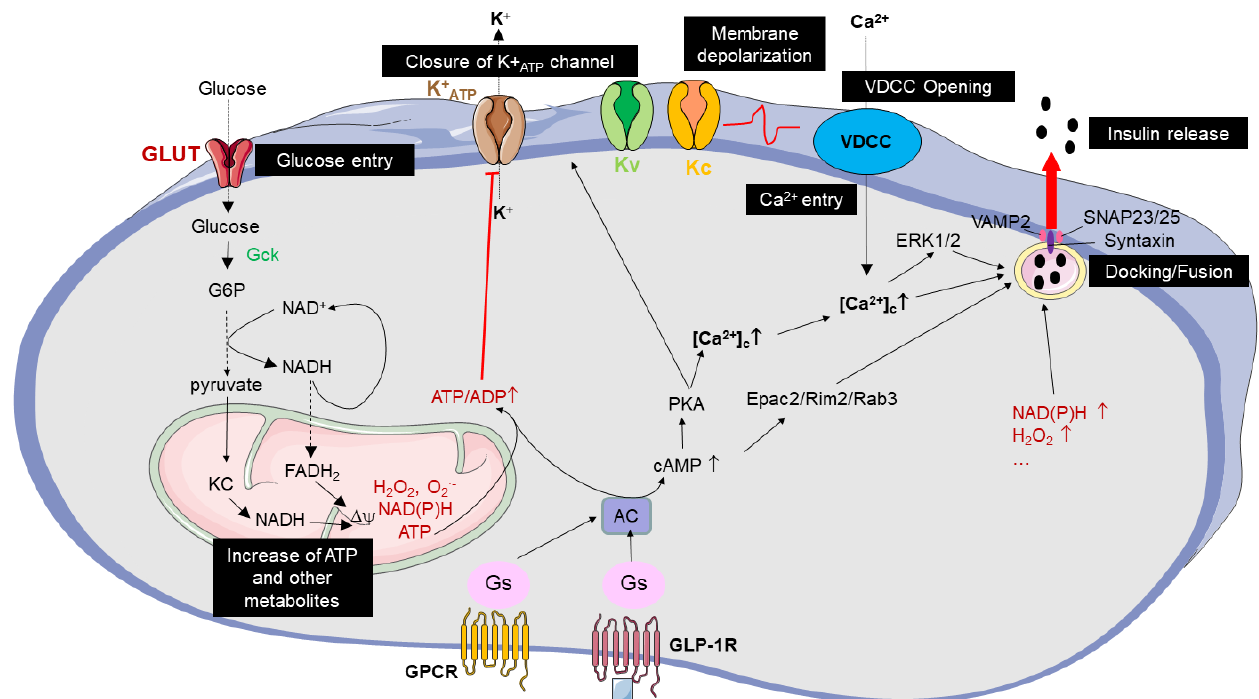
Figure 1. Triggering and amplifying pathways coupling glucose to insulin secretion. Glucose enters via glucose transporters (GLUTs) and increases the ATP/ADP ratio by glycolytic and TCA metabolism. Then, ATP promotes the closure of K + channels, which stops the K + efflux. This leads to membrane depolarization and the opening of voltage-dependent calcium channels (VDCCs). The entry of Ca + could activate the mitogen-activated kinases ERK/2, which together fosters the fusion of insulin-containing granules with the plasma membrane, and finally the release of insulin into the extracellular compartment. The triggering pathway is followed by the amplifying pathways which involve GLP-1R and other G s -protein coupled receptors (GPCRs), and several metabolites including NADH/NADPH, radical species, H 2 O 2 , and lipidic metabolites. All of these can promote the granule docking, fusion and finally, insulin exocytosis. Granule fusion entails the pairing of the (v)-SNARE (VAMP2) and t-SNAREs (SNAP-25/23 and Syntaxin) proteins, forming a binary cognate target membrane receptor complex. After insulin release, the membrane repolarization involves Kv and Kc channels. GCK: glucokinase, Kv: voltage-dependent potassium channel, Kc: calcium-activated potassium channel, G6P: glucose-6 phosphate, AC: adenylate cyclase, PKA: Protein protein 2, SNAP23/25: synaptosome-associated proteins 23/25